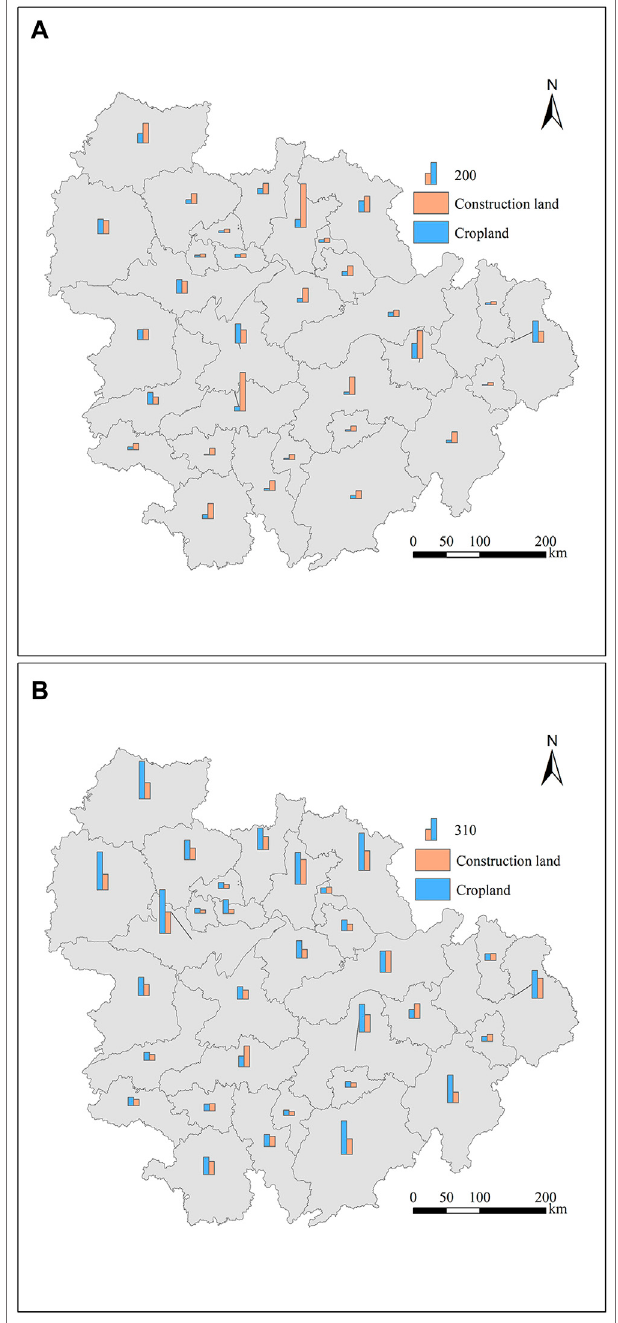
FIGURE 3 | Area of the expanded construction land and the expanded cropland in the subresearch area in the periods of (A) 2000 – 2010 and